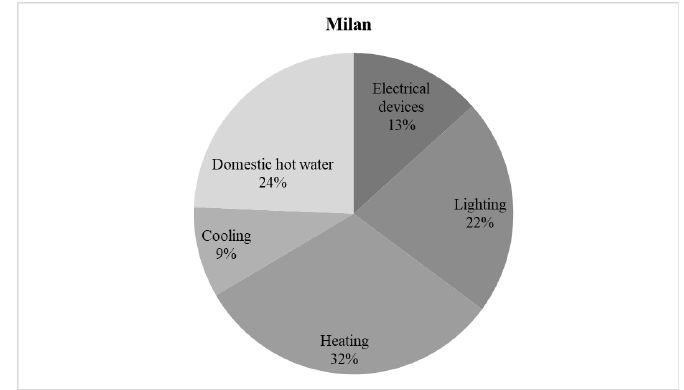
Figure 8. Entire yearly demand of primary energy (kWh/m 2 y) for the three analysed solutions in the case of Milan.